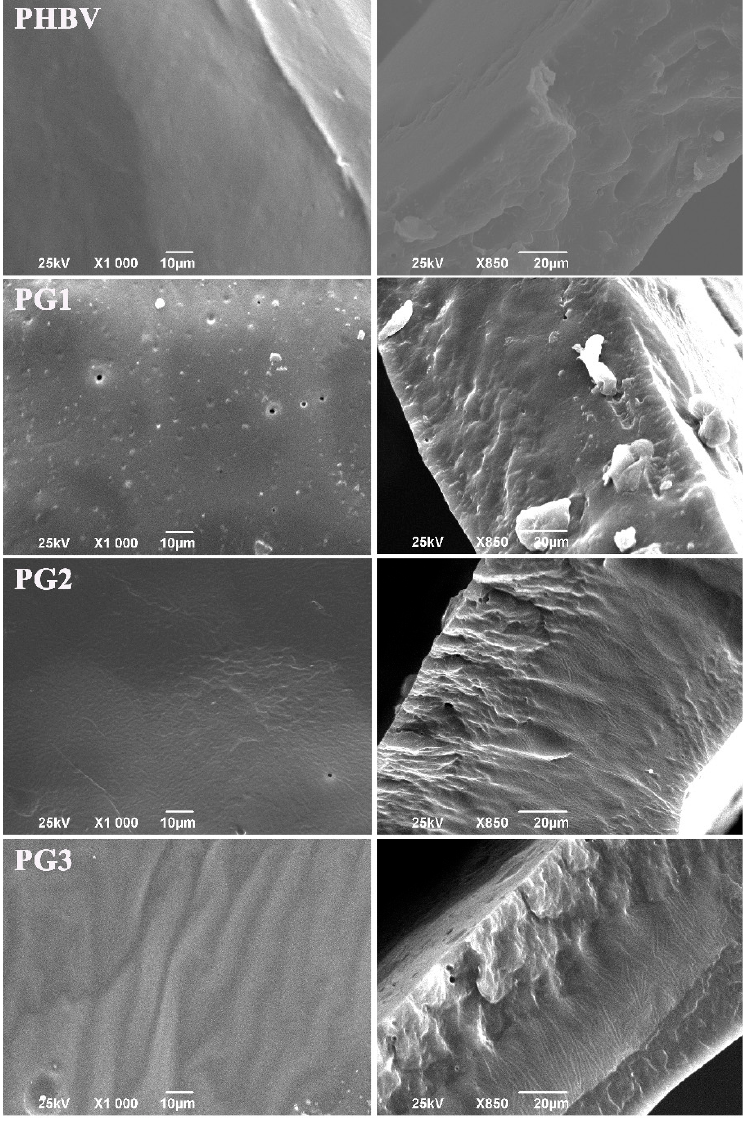
Figure 2. SEM micrographs of the surface and corresponding cross-sections of the neat biopolymer (PHBV) and the bacterial pigment containing (PG1, PG2 and PG3) films.